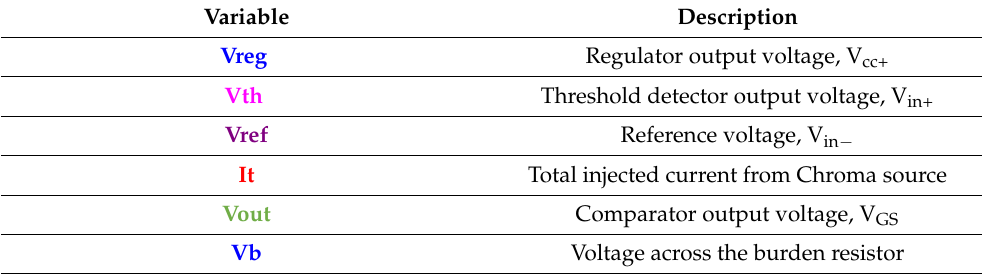
Table 4. Description of the plot